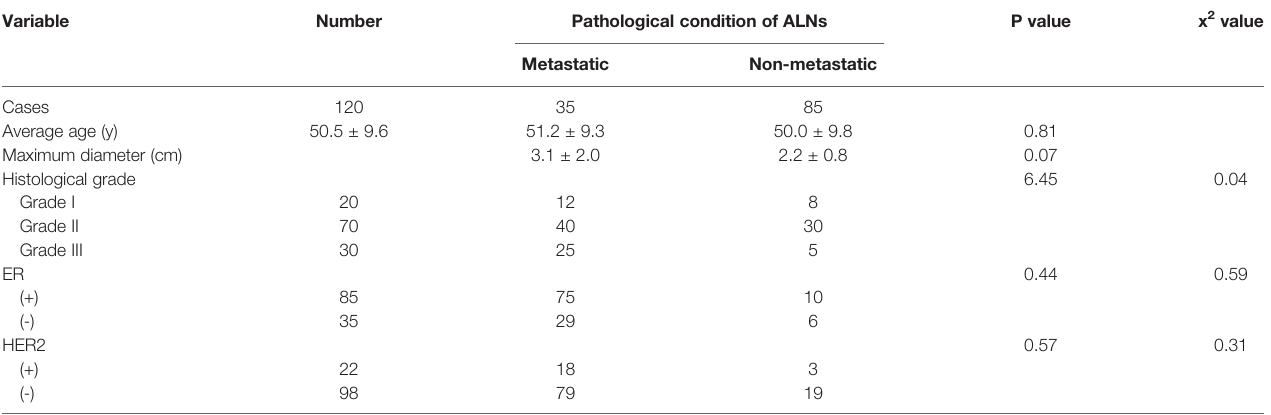
TABLE 1 | Comparison of clinicopathologic factors and ALN metastasis in patients with breast invasive ductal carcinoma.